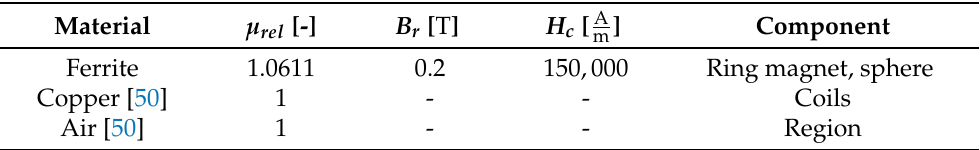
Table A1. Data for the linear materials used in the FE model of the catch actuator. µ rel is the relative permeability, B r the remanence, and H c the